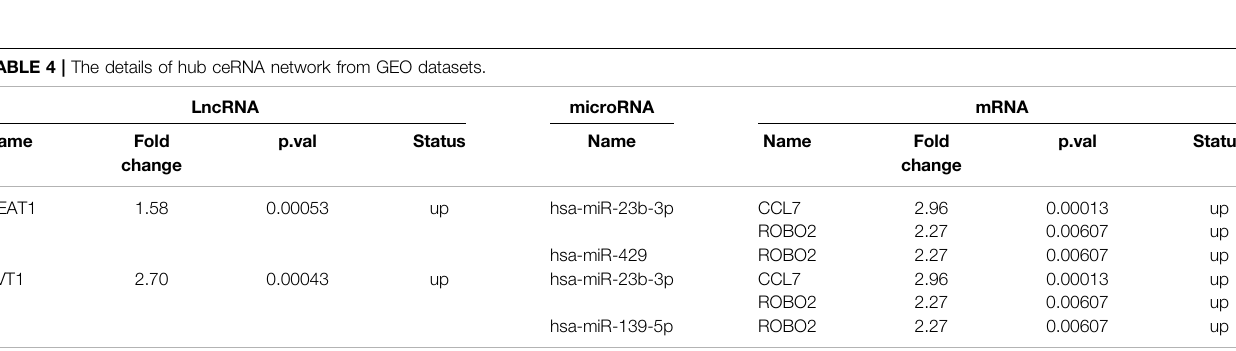
TABLE 4 | The details of hub ceRNA network from GEO